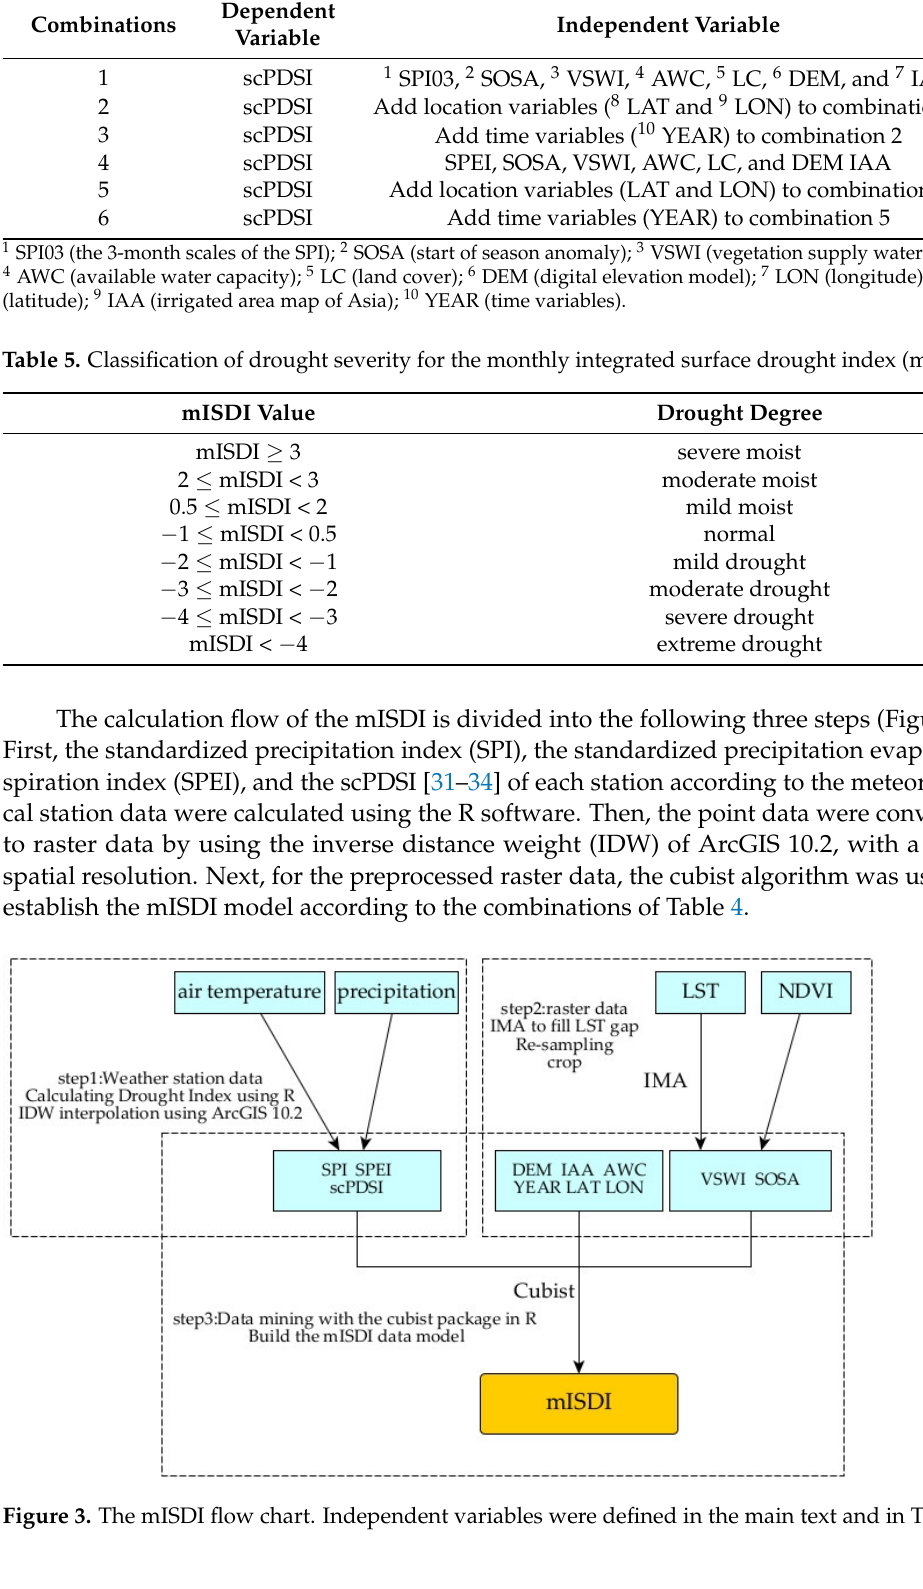
Independent Variable